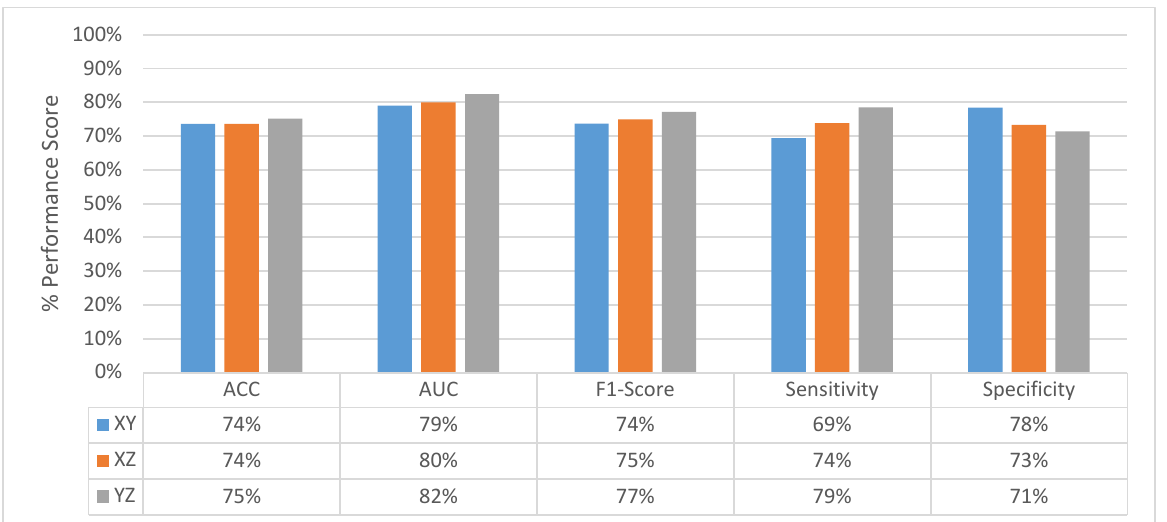
Figure 11. MPF model—change in slice-level classification performances across different perspec- tives.